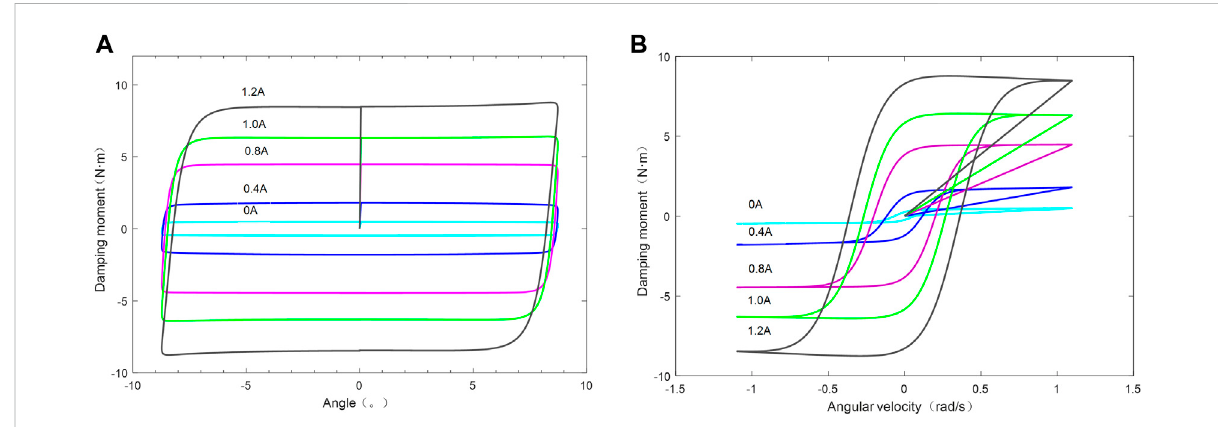
FIGURE 4 Mechanical characteristics of MRTD; (A) Angular rotation; (B) Angular